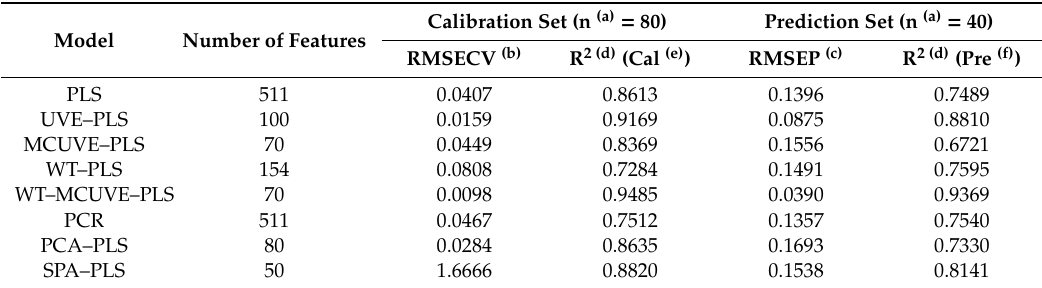
Table 4. Comparison of calibration results and prediction results obtained with the use of partial least-squares (PLS), uninformative variable elimination (UVE)–PLS, Monte Carlo